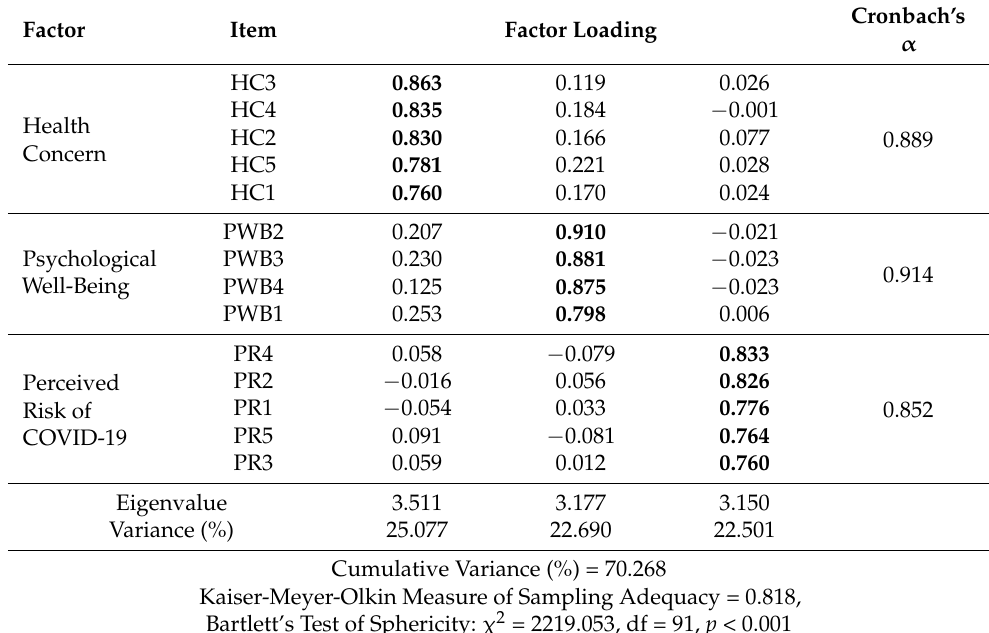
Table 4. Exploratory factor analysis and